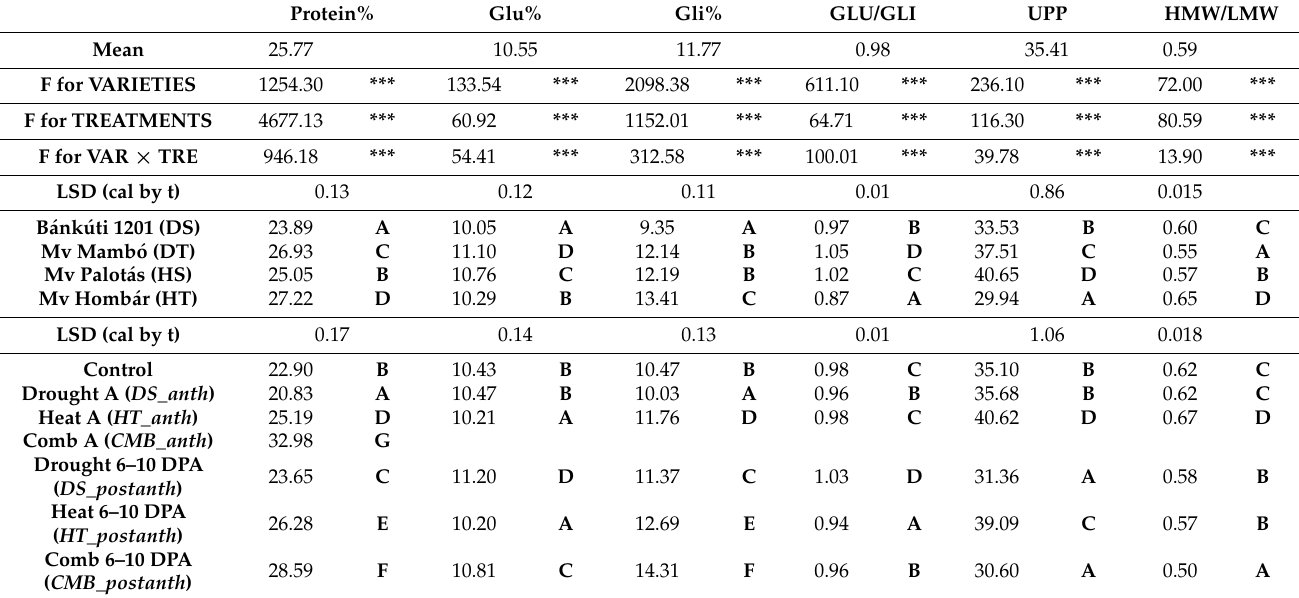
Table 2. The alteration of protein composition caused by the different abiotic